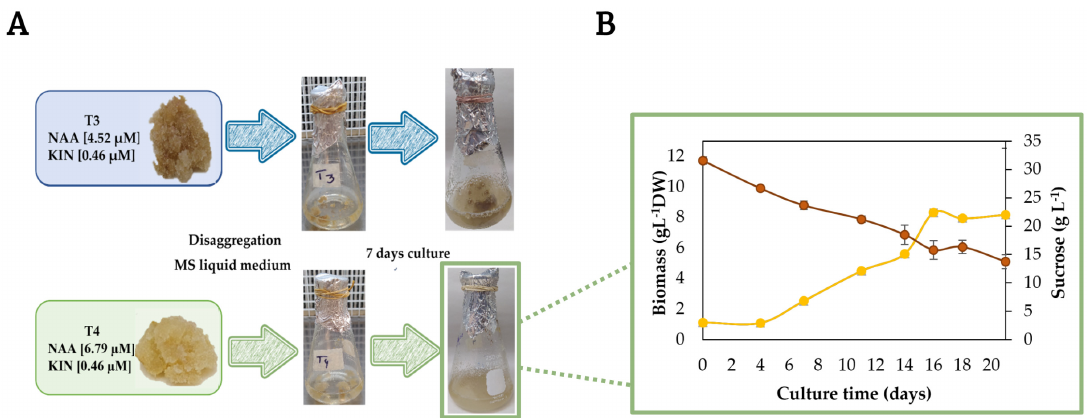
Figure 2. ( A ) Establishment of A. pichichensis cell suspension culture (CSC) in liquid Murashige and Skoog medium (MS) from callus culture (CC) treatments T3 and T4, maximum disaggregation in CSC was achieved at seven-day culture. ( B ) Kinetic growth of T4 suspension cell culture (CSC) during 21 days of culture.